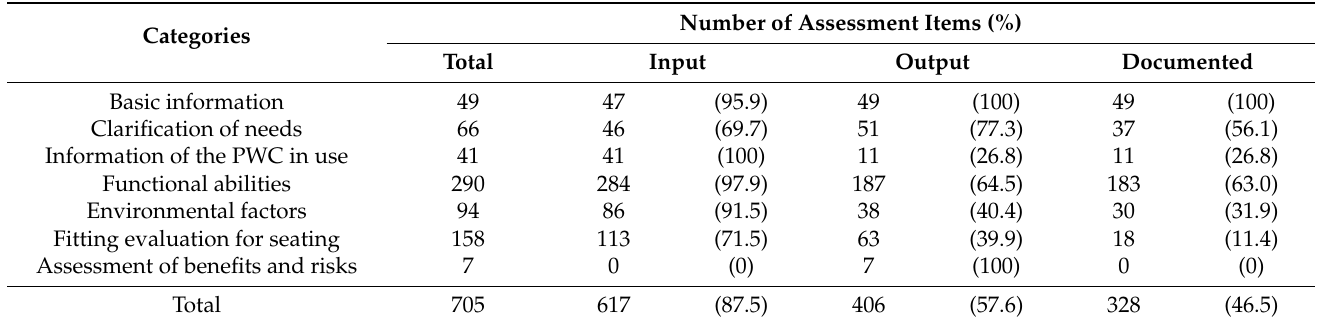
Table 3. Communicating directions and documentation statuses of the assessment